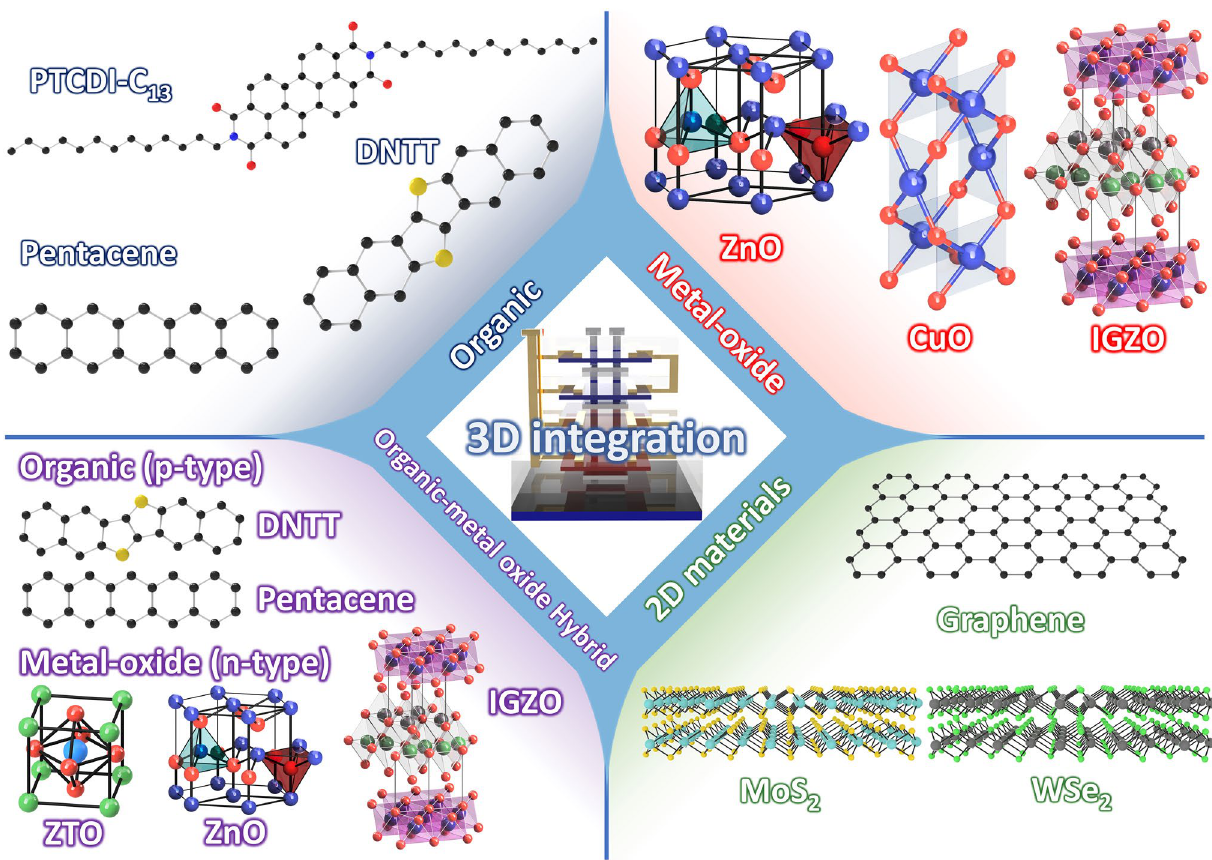
Fig. 1 Overview of 3D integration based on emerging materials, including organic semiconductors, metal oxide semiconductors, and 2D mate-